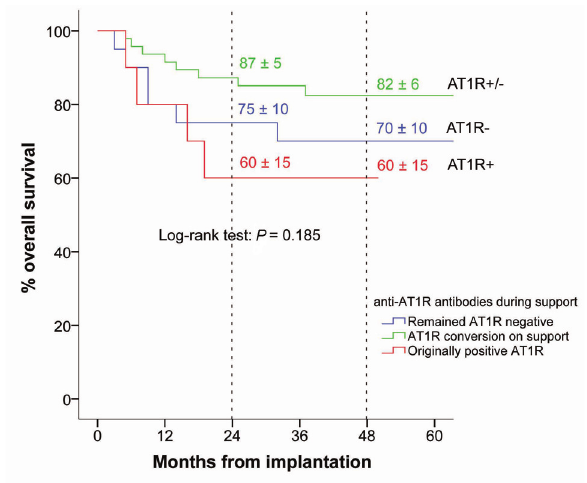
Fig. 2. Overall survival of HeartMate II recipients stratified according the presence of anti-AT1R